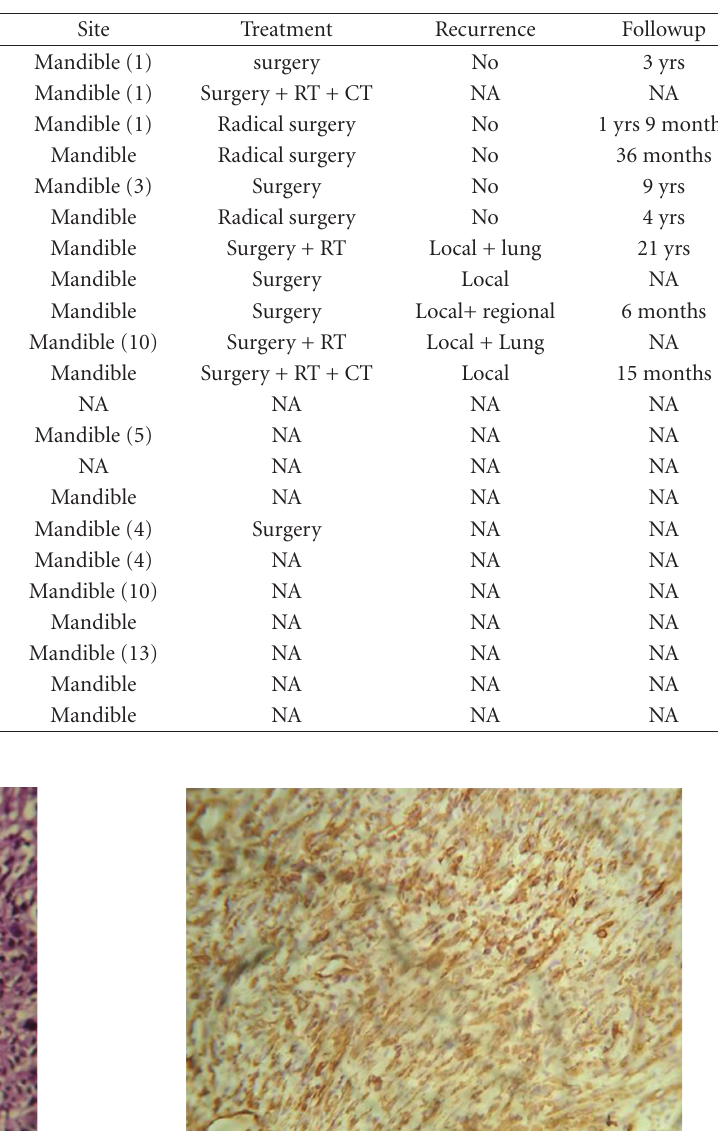
Table 1: Cases of primary fibrosarcoma of mandible reported in the literature.